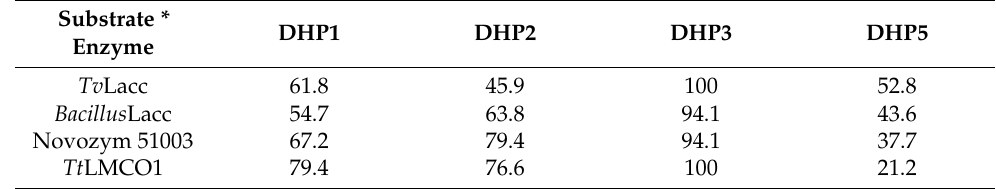
Table 2. DHP1-DHP6 biotransformation with four laccases assessed by HPLC with the amount of sub- strate remaining after 18 h reaction expressed as %. Chromatograms are given in supporting material.